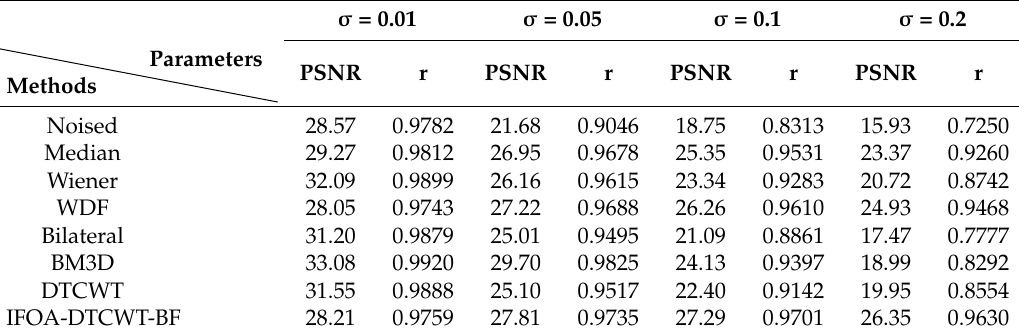
Table 6. Comparison of the six methods (Columbia with Speckle noise).